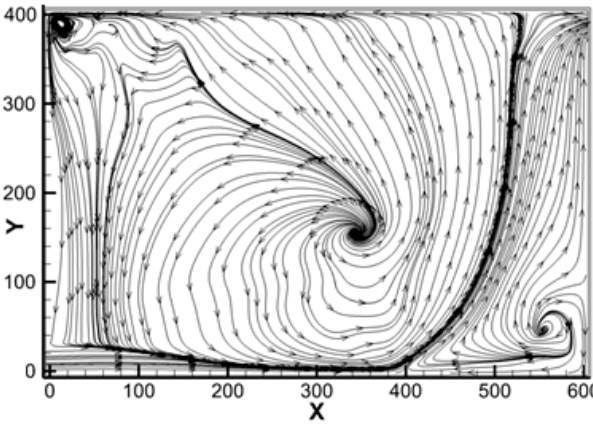
Figure 8. Stream Lines 15.5 cm from the bed, G3716 reservoir.